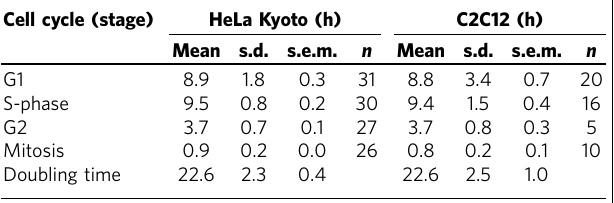
Table 1 | Cell cycle (stage) duration measurements. Cell cycle